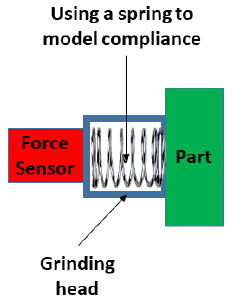
Figure 8. Spring system of the compliant head.